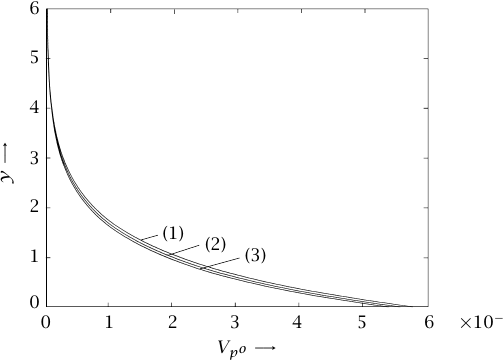
Figure 4.7 . Outer flow transverse velocity component of particle V p o for R = 500, 4 = 0 . 05, t = 2. (1) X = − 1, λ = 0 . 01, (2) X = − 1, λ = 0 . 16, (3) X = − 1, λ = 0 .